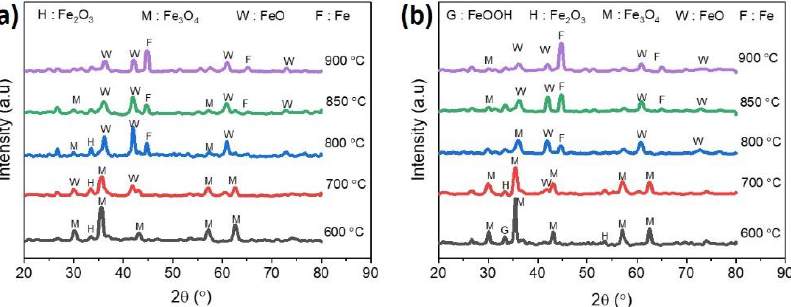
Figure 7. XRD pattern of samples after reduction process from 600 – 900 °C for 1 h with a heating rate of ( a ) 10 °C/min; ( b ) 20 °C/min.